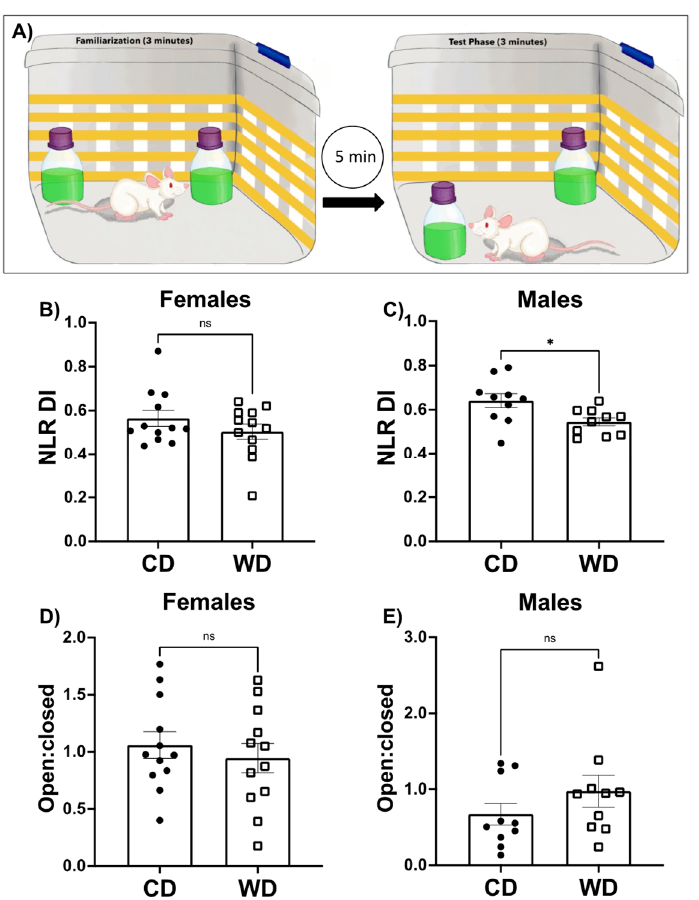
Figure 3. Impact of a Western diet (WD) or chow diet (CD) on performance in neurocognitive tasks. A cartoon representation of the hippocampal-dependent novel location recognition task is shown in ( A ). Following 3 min of familiarization with two identical objects placed in opposite corners of an arena during which time rats equally explore the objects, rats are removed from the arena for 5 min. The rat is then returned to the cleaned arena with the same two objects, but one of the objects is moved to a novel location in the box. Time spent exploring the object in the novel location divided by the total time exploring both objects during the test phase gives a discrimination index score (DI) which is shown for females ( B ) and males ( C ). Results from the elevated plus maze (EPM) are shown for females ( D ) and males ( E ) as the ratio of time spent in the open arm/time spent in the closed arm (open: closed). Data are analyzed using a two-tailed Student’s t Test. Data are shown as the means × SEM. * p < 0.05 .